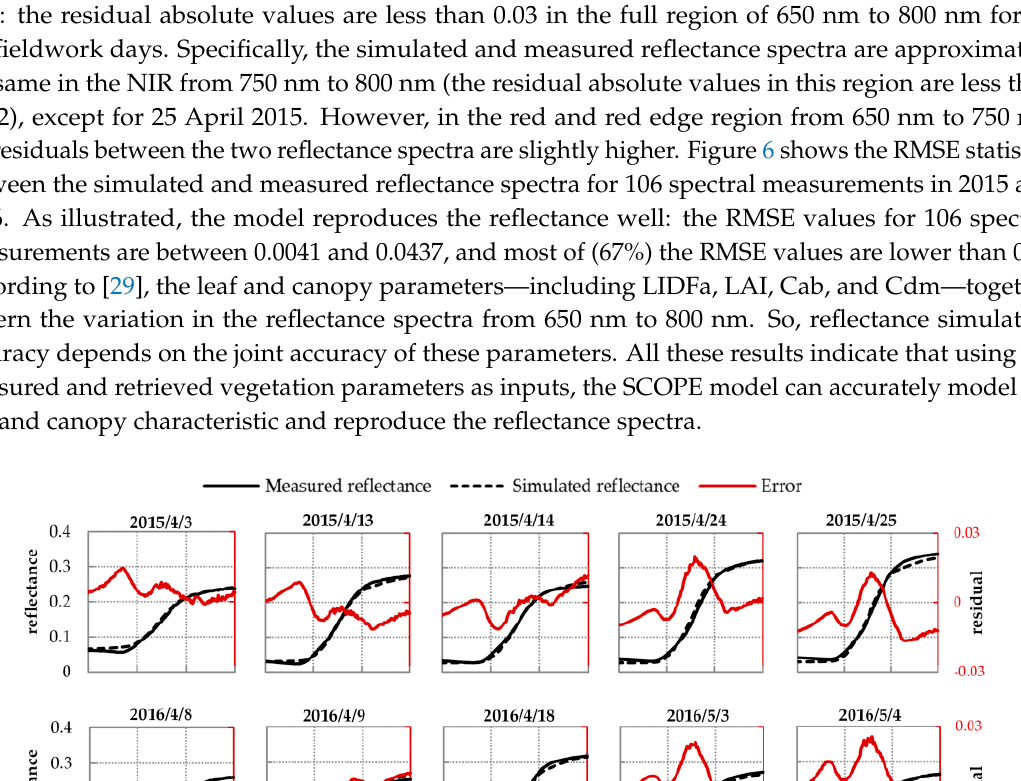
Figure 6. Root mean squared error (RMSE) values between the simulated and measured reflectance spectra for 106 spectral measurements in 2015 and 2016. Figure 7 shows the diurnal cycles of the simulated and measured GPP on ten fieldwork days in 2015 and 2016. On one hand, the absolute intensities of the two GPP data sets (simulated and measured diurnal GPP) agree well: the RMSEs of two GPP data sets range from 1.514 μ mol m − 2 s − 1 to 5.627 μ mol m − 2 s − 1 , and the corresponding relative root mean square error (RRMSE) values range from 10.31% to 29.65% on the ten fieldwork days. On the other hand, the diurnal patterns of simulated GPP agree well with measured GPP on most fieldwork days, except for 18 April 2016, when the GPP observations were likely inaccurate and inconsistent with the PAR changes (see